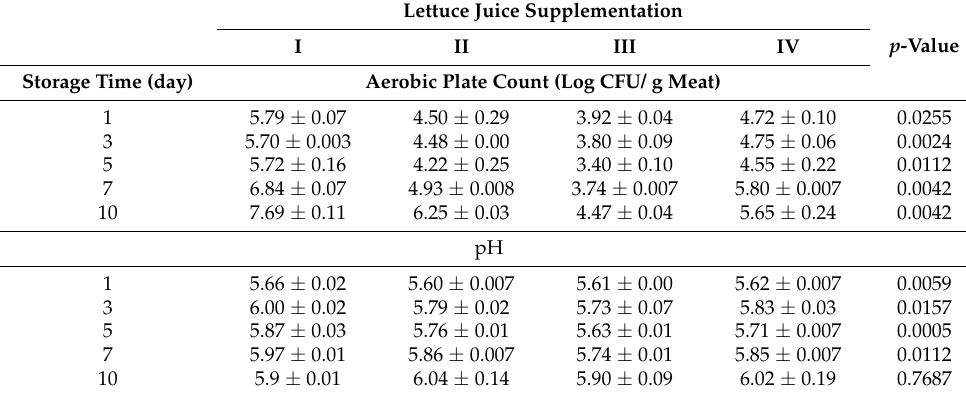
Table 11. Storage shelf life of rabbit minced meat stored for 10 days at 5 ± 0.2 ◦ C. Meat samples were taken from rabbits. Administered lettuce juice fertilized with nitrate or WPH (groups III and IV, respectively) as compared to that of nonfertilized lettuce or lettuce-free diet (groups I and II,